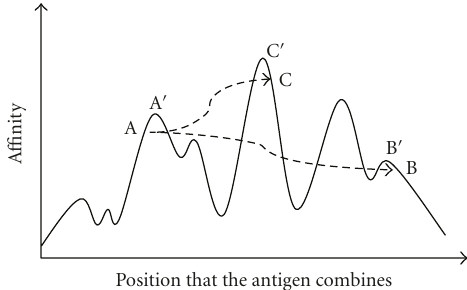
Figure 3: Schematic representation of receptor